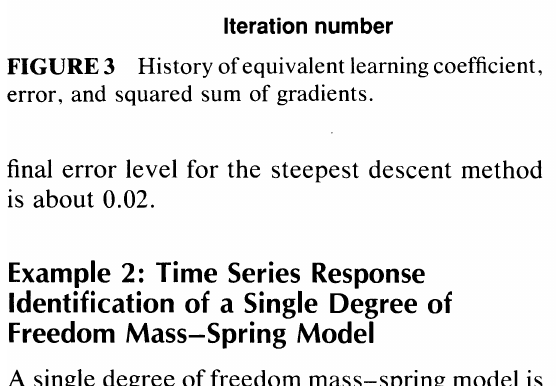
FIGURE 5 Input and output variables of neural net work for mass-spring model.